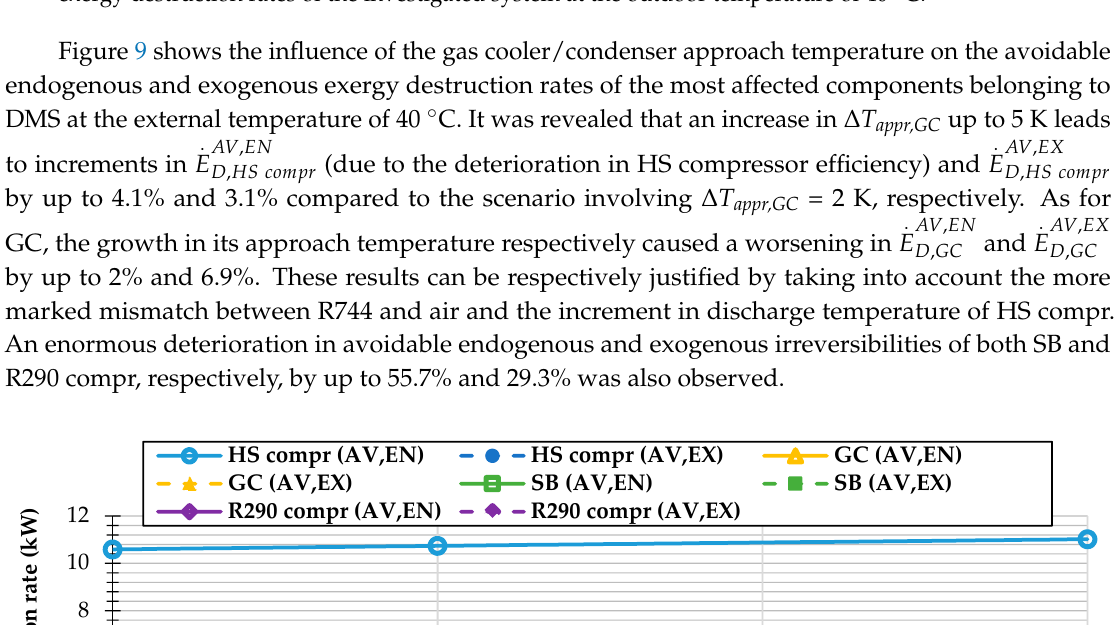
Figure 8. Effect of the gas cooler/condenser approach temperature on the avoidable and unavoidable exergy destruction rates of the investigated system at the outdoor temperature of 40 °C.